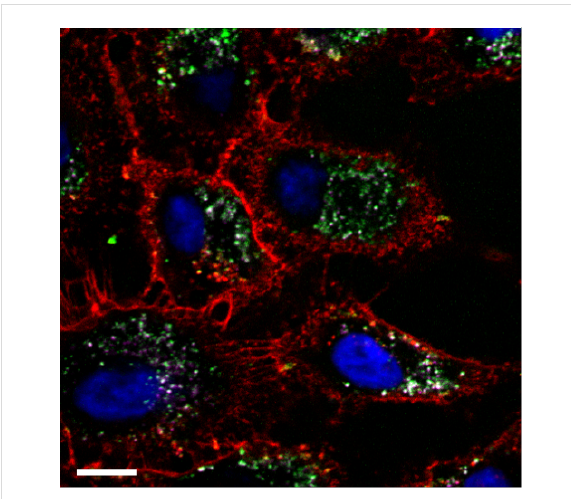
Figure 4: Fluorescence microscopy image showing the granular struc- ture of internalized NPs inside A549 lung cancer cells (two types of iron oxide NPs with different surface chemistry, labelled with different fluorophores (green and magenta)) after 24 h of incubation at a concentration of 1 µg/mL, which are located in individual vesicles. Nuclei are stained with DAPI (blue) and the cell membrane with Wheat Germ Agglutinin (red). Note that due to limited lateral resolution of optical microscopy the spots most likely do not correspond to indi- vidual NPs, but to several NPs, which are entrapped inside intracel- lular vesicles. The scale bar represents 5 μ m. Adopted with permis-